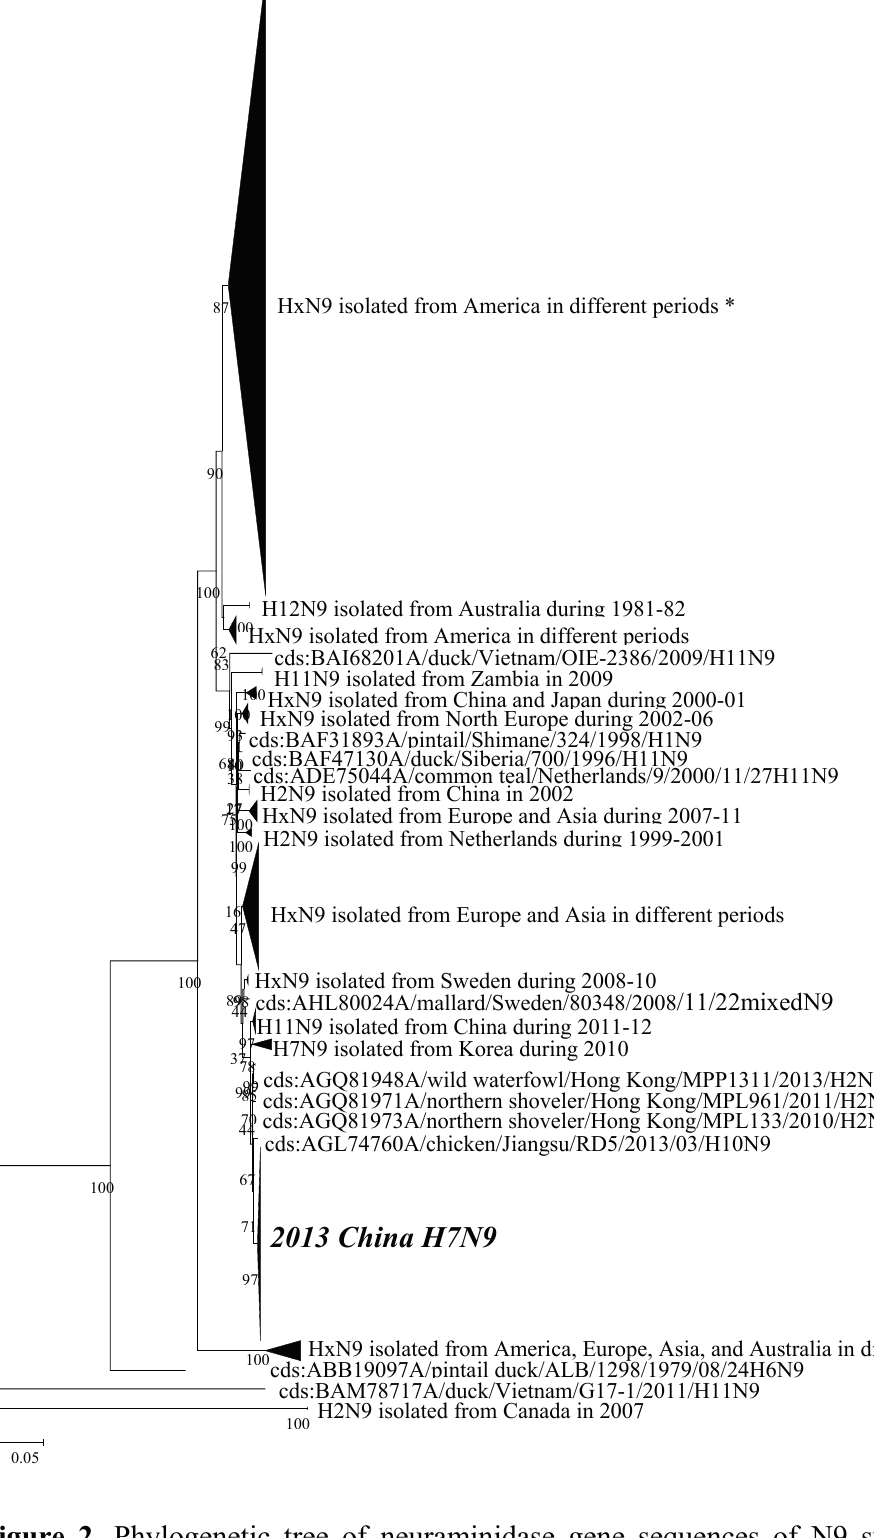
Figure 2. Phylogenetic tree of neuraminidase gene sequences of N9 subtype influenza A viruses. It indicated that the novel H7N9 AIVs isolated in China 2013, whether or not they were characterized by the deletion of amino-acids 69 to 73 in the neuraminidase stalk, shared very close homogeneity. * Note, x such as in HxN9 indicated that there was more than one subtype HA in the